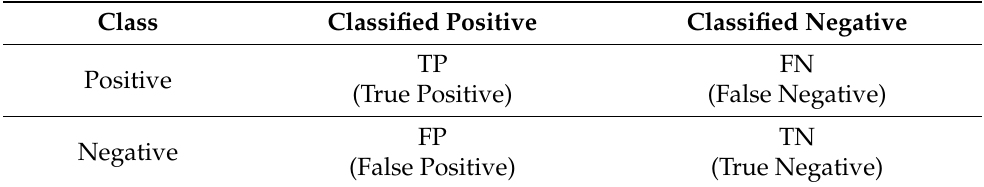
Table 3. Confusion matrix